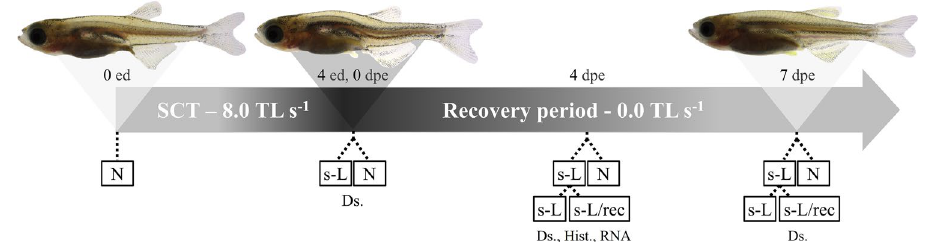
Figure 4. Basic experimental design. Juvenile zebrafish with normal external morphology were subjected to a swimming challenge test (SCT) for the induction of haemal lordosis. The severe lordotic (s-L) and normal (N) fish were monitored for a week under almost 0.0 TL s −1 . Lordosis recovery (s-L/rec) was examined by means of double staining for bone and cartilage (Al.), histology (Hist.) and gene expression analysis (RNA). ed, exercise days. dpe, days post